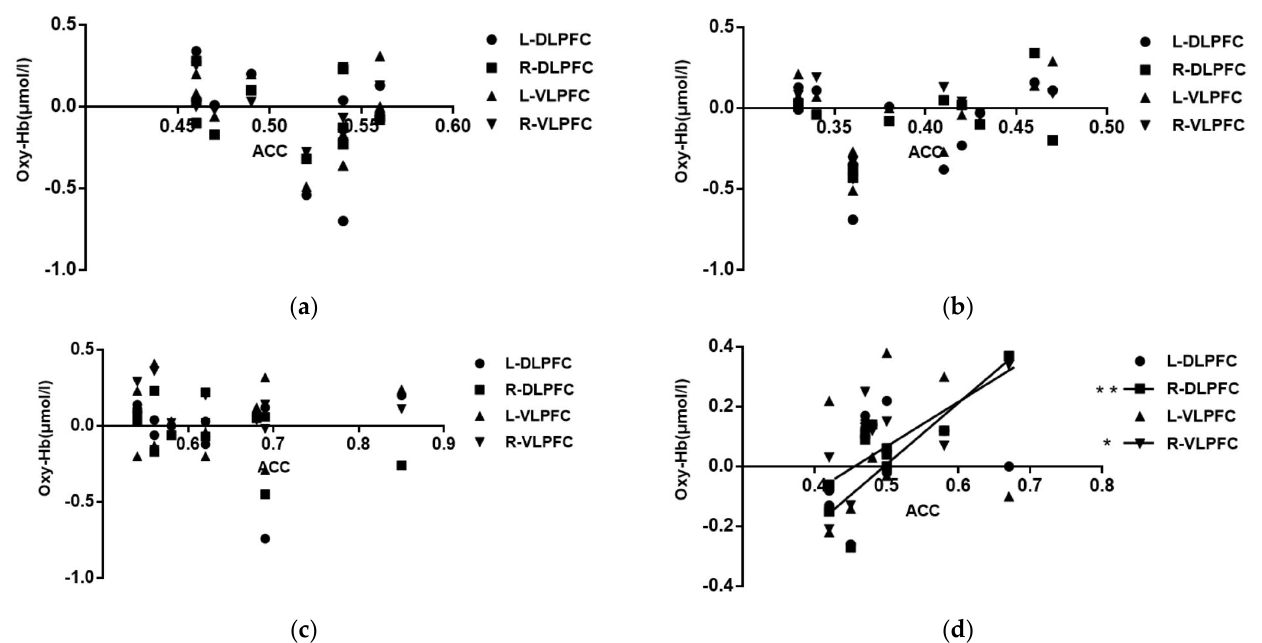
Figure 7. Correlation between Oxy-Hb concentration in the region of interest and the correctness rate (Note: * represents 0.01 < p < 0.05, ** represents p < 0.01). ( a ) Novice group simple map; ( b ) novice group complex map; ( c ) expert group simple map; ( d ) expert group complex map.